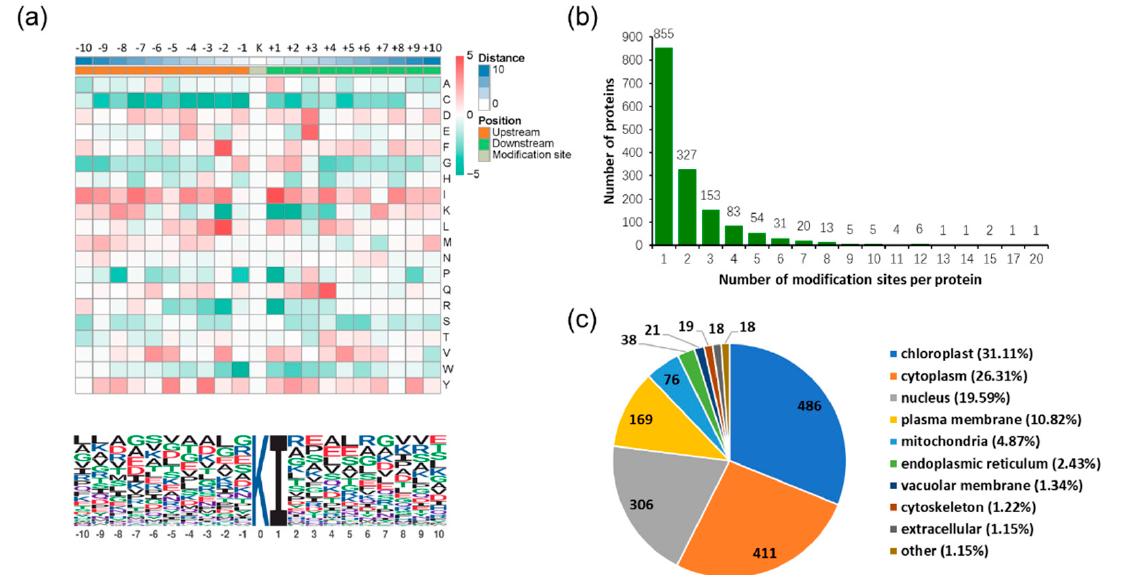
Figure 2. Ubiquitinated lysine motifs and proteins in S. japonica . ( a ) Motif analysis of all the identified sites. In the heat map, the p value matrix was transformed by the function x = log10 ( p value) when fold change < 1, and transformed by the function x = − log10 ( p value) when fold change > 1. The red indicates that this amino acid is significantly enriched, and green indicates that this amino acid is significantly reduced. The height of each letter in the conserved domain corresponding to the frequency of the amino acid residue in that position. ( b ) The number of modified sites in the detected diglycine-modified peptides. ( c ) The subcellular location of all differential proteins.